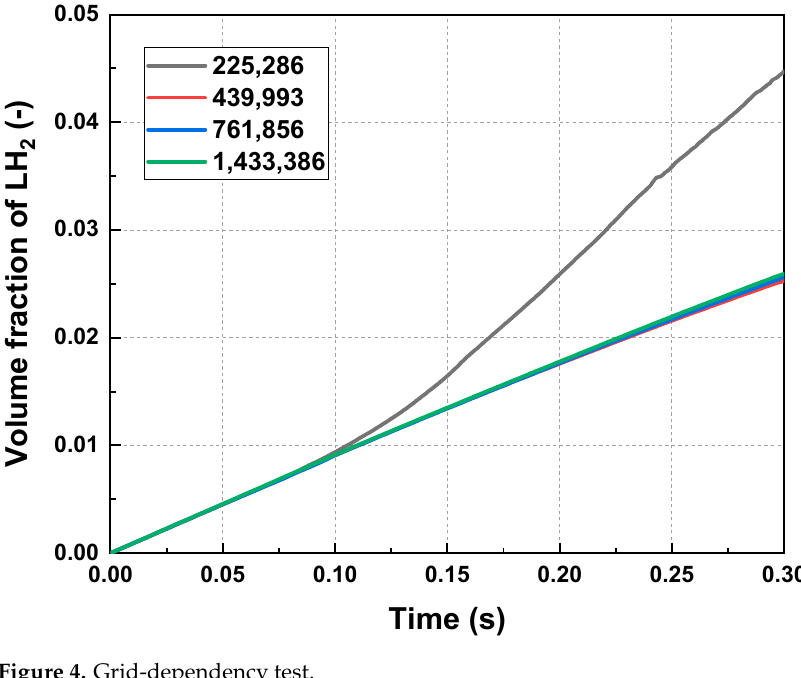
Figure 4. Grid-dependency